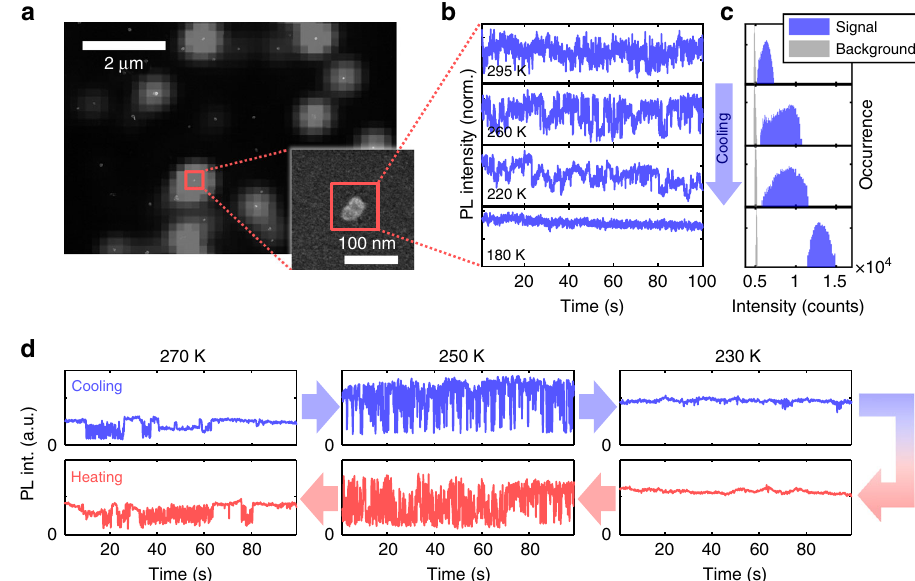
Fig. 2 Exemplary blinking data. Overlapped SEM and PL microscopy images and a detailed image of one of these crystals are presented in a , for more SEM data and more detailed analysis see Supplementary Note 1. From quantitative analysis of this data we estimate an average crystal diameter of 70 nm. Panel b shows normalized temperature-dependent PL intensity traces extracted from this crystal. Panel c summarizes the corresponding intensity histograms with logarithmic vertical axis. Panel d shows intensity traces recorded for heating and cooling of another crystal, exemplifying that the blinking characteristics are reproducible and very sensitive to a small change of temperature. All plots in d are shown with the same intensity seem to be present in the crystals investigated here (see e.g. Figure 1j), they cannot be the only source of irregularities in the temperature dependent PL quantum yield. Direct evidence for the in fl uence of individual quenching sites is also given by the pronounced blinking behavior 23,25 – 30 . Below we will characterize the temperature dependence of blinking in order to establish its connection to the PL quantum yield.